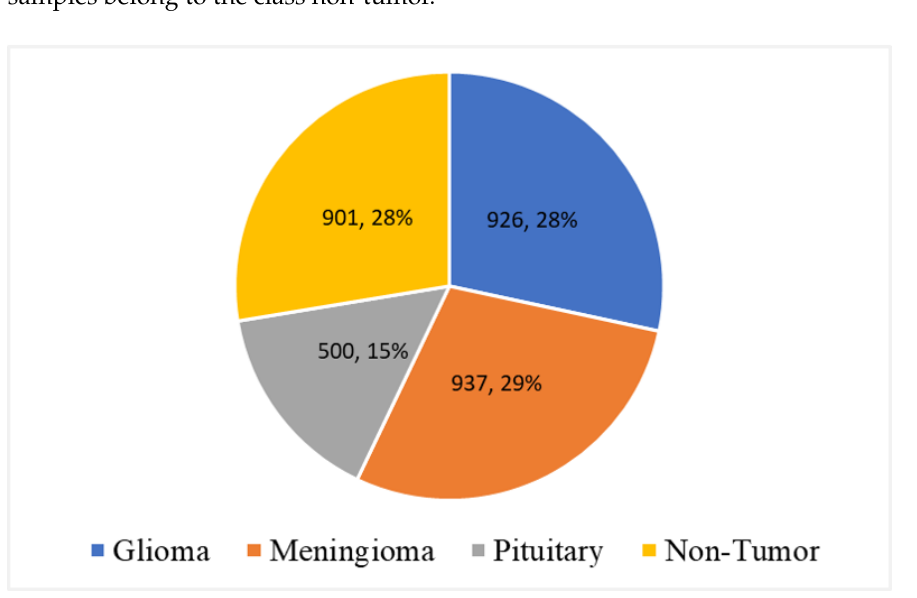
Figure 7. Data distribution analysis according to class